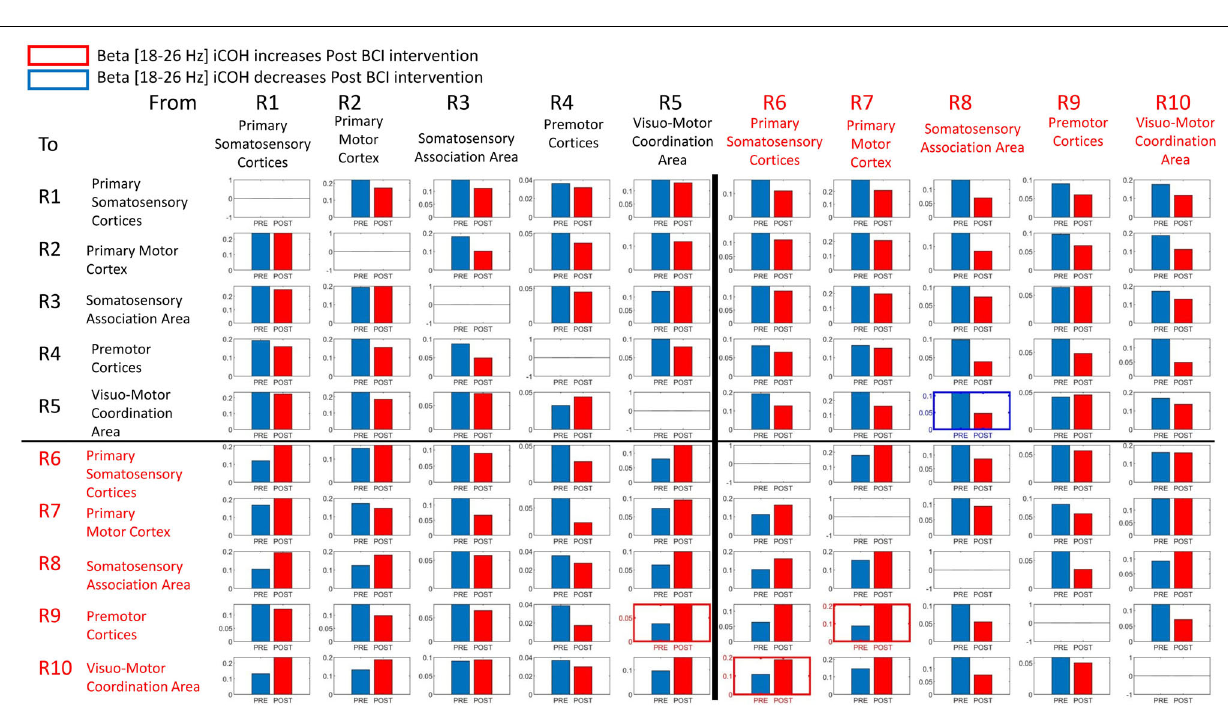
Frontiers in Human Neuroscience |